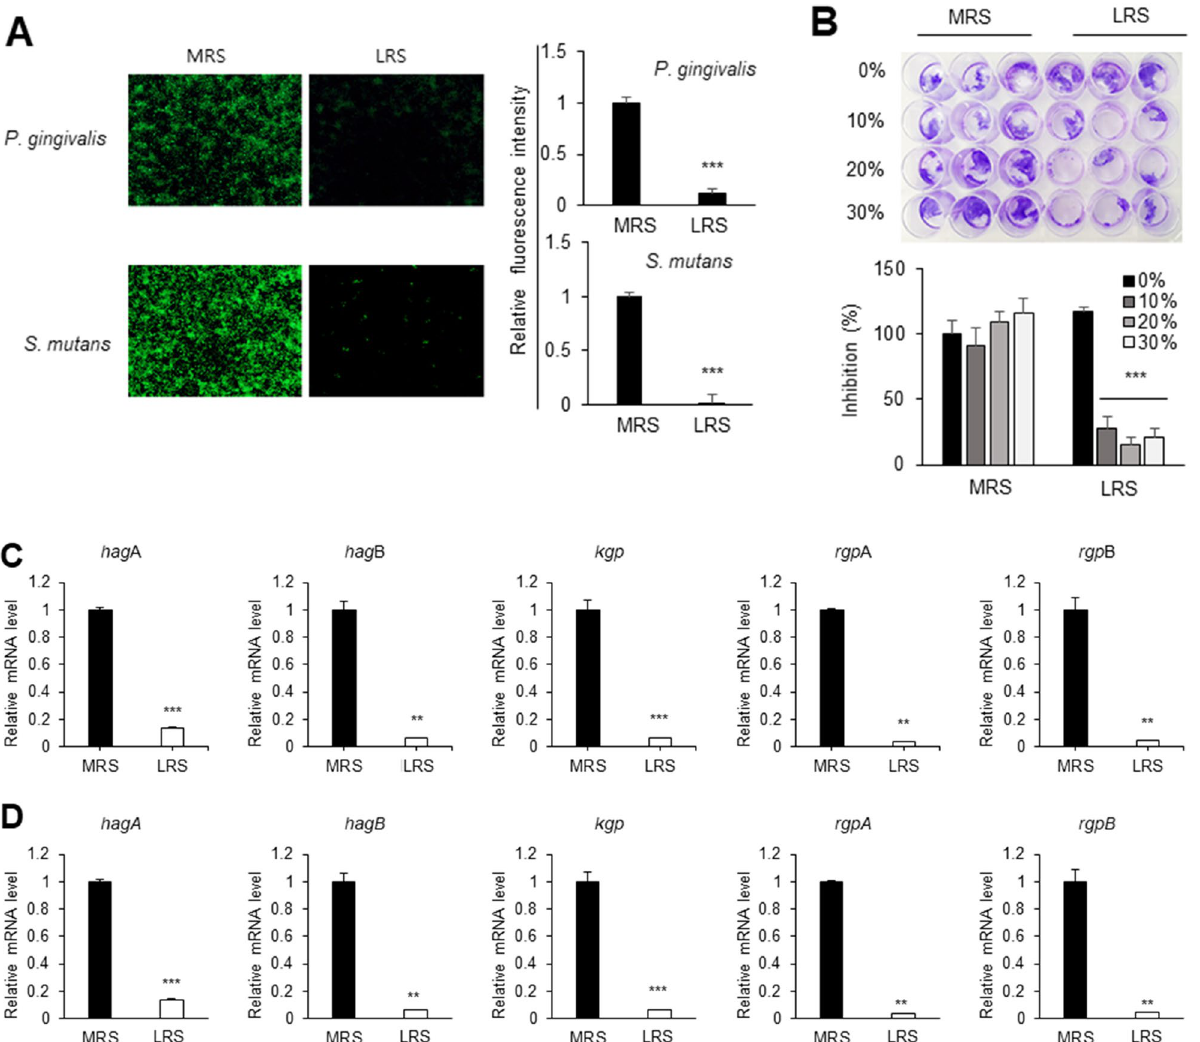
Figure 4. Activity of LRS against P. gingivalis and S. mutans biofilm formation ( A ) Visualization using fluorescence microscopy (left panel) of the antibiofilm effect of LRS. Non-adherent bacteria were removed, and the biofilms stained using the LIVE/DEAD BacLight Bacterial Viability Kit. Green and red fluorescence indicates live and dead bacteria, respectively. The fluorescence intensity ratio of live/dead cells (right panel) was analyzed using ImageJ software (IJ version 1.46r; https ://image j.nih.gov/ij/downl oad.html). Significant differences from the control ( p < 0.001) are indicated by ***. ( B ) Images showing crystal violet-stained